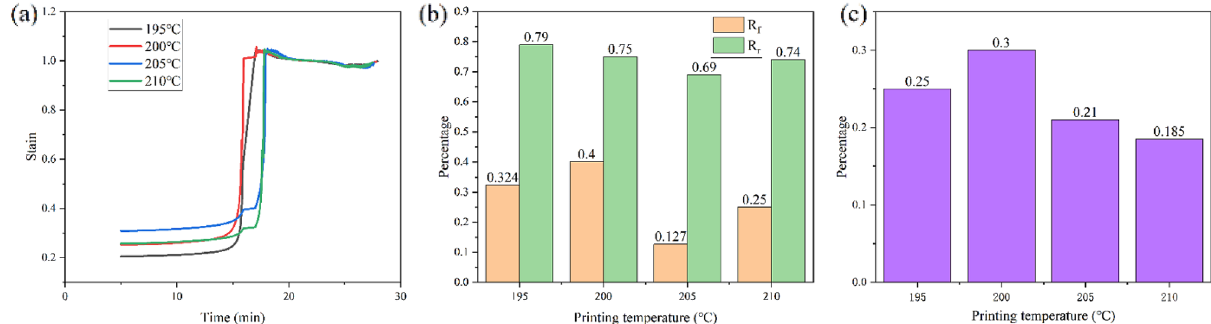
Figure 6. ( a ) DMA strain at different printing temperatures; ( b ) the R r and R f at different printing temperatures; and ( c ) the R at different printing increased—all above the initial glass transition temperature of 65 degrees for PLA. When the printing tempera- ture exceeded 200 degrees, the magnitude of the change in the physical properties diminished as it approaches its melting temperature. The storage modulus curve is divided into a high temperature zone (75–130 °C) and a low temperature zone (15–60 °C). In the low temperature zone between 15 and 60 °C, the material was glassy (similar to glass under the action of external forces producing small deformation), and the storage modulus became larger. From 60 to 75 °C, the material rapidly changed from a glassy state into a high elastic state—that is, during the glassy body transformation process, the storage modulus decreased rapidly. In the high temperature zone from 75 to 110 °C, the material was in a high elastic state (similar to rubber, the deformation produced under the action of external forces was larger); in the late part of this temperature zone, the deformation remained unchanged, and the storage modulus was low; when the temperature continued to rise above 110 °C, the material assumed a viscous flow state. The deformation at this stage was not reversible, and the storage modulus increased again, but the trend was slower. By collating the maximum value of the storage modulus in the low temperature region with the maximum value of the storage modulus in the high temperature region, the glass transition temperature, and their corre- sponding loss factors at different printing temperatures, we obtained the changes in the parameters under differ- ent printing temperatures. The maximum value of the storage modulus in the low-temperature region decreased with an increase in printing temperature, reaching a minimum value of 1324 MPa at 205 °C and slightly increas-